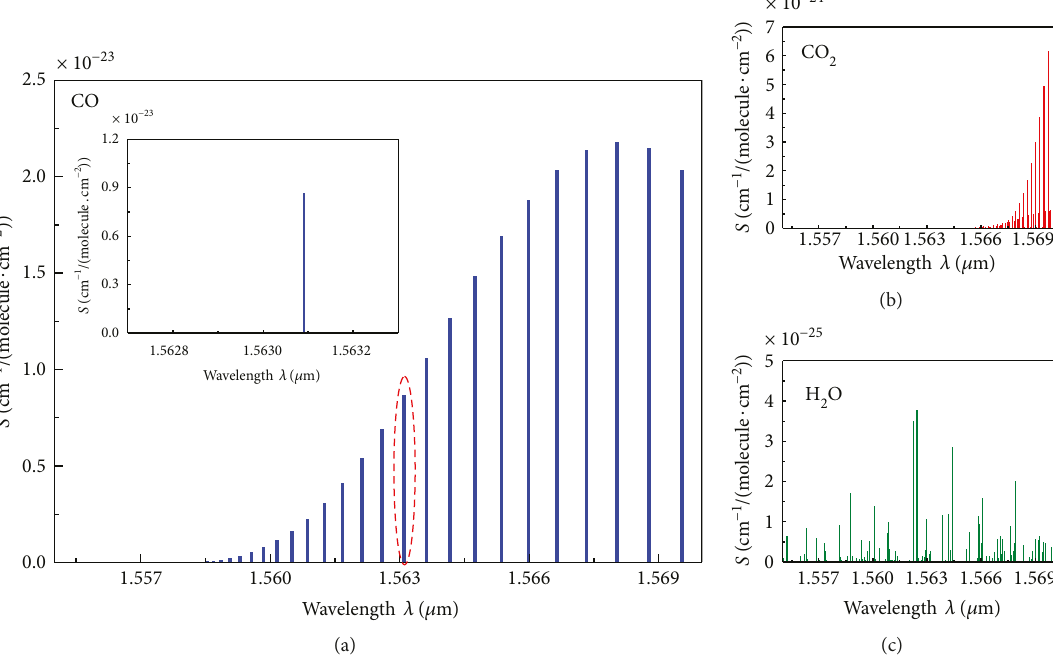
Figure 1: Absorption line of carbon monoxide (a), carbon dioxide (b), and H